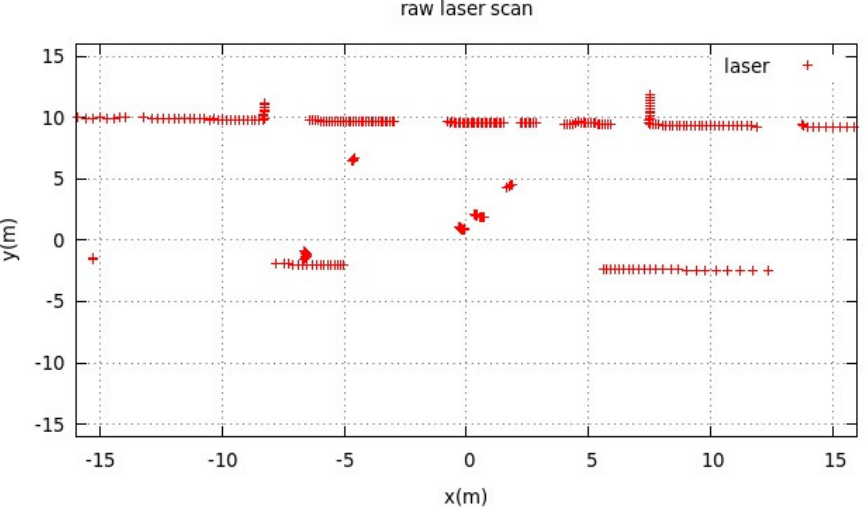
Figure 3. Raw Laser Data. It shows laser points readings during the experiment when multiple humans are moving in the test area.